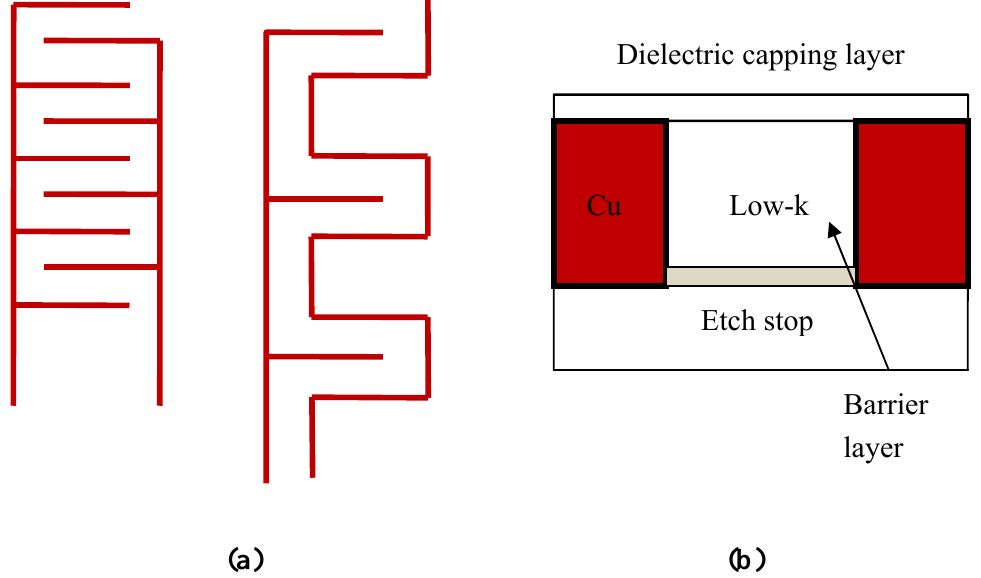
Figure 1. (a) Comb-comb and comb-serpentine test structures for TDDB testing; (b) Cross sectional schematic of single damascene copper low-k